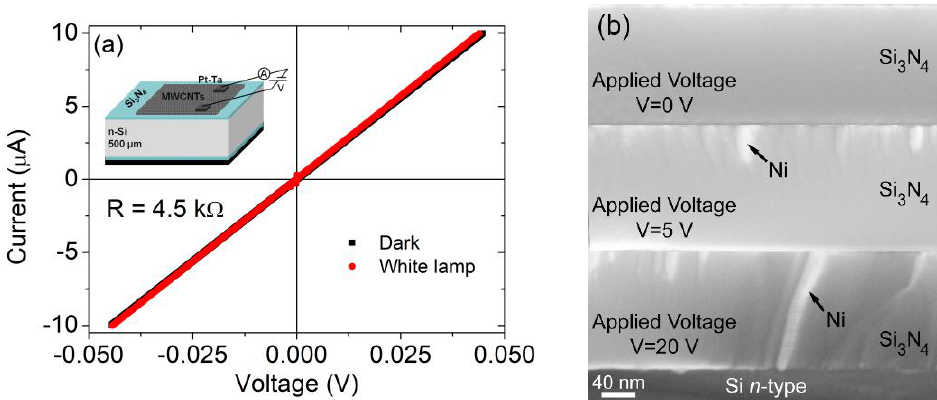
Figure 2. ( a ) I-V characteristics measured between the two top Ta-Pt pads for the Ta-Pt / CNT / Ta-Pt heterostructure. ( b ) SEM images showing the formation of Ni filaments in the Si 3 N 4 layer after electric stress at increasing voltage.